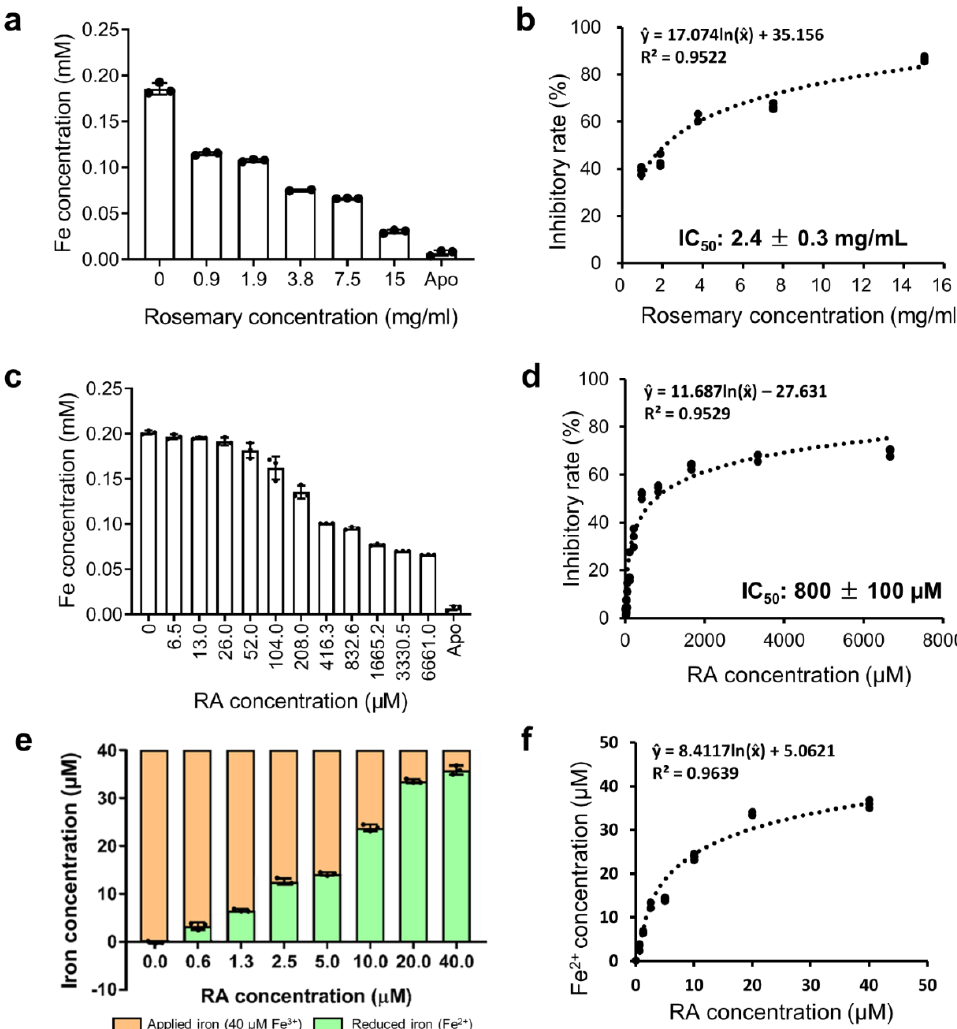
Figure 2. ( a ) The remaining Fe concentrations in the eluents after inhibition assays using rosemary extracts. ( b ) Inhibitory rates of rosemary extracts. A nonlinear regression model was performed to fit the concentration (rosemary) − response (inhibitory rate) data. ( c ) The remaining Fe concentrations in the eluents after inhibition assay using RA. ( d ) Inhibitory rates of RA. A nonlinear regression model was performed to fit the concentration (RA) − response (inhibitory rate) data. ( e ) The reduced Fe 2+ concentration after adding RA (0, 0.6, 1.3, 2.5, 5, 10, 20, and 40 μM). Orange bar, applied Fe 3+ (40 μM). Green bar, reduced Fe 2+ from Fe 3+ by RA. ( f ) A nonlinear regression curve fitting of the concentration (RA) − response (Fe 2+ ) data.